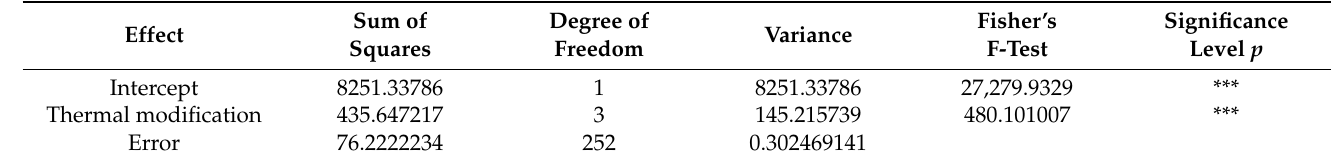
Table 4. Statistical evaluation of the factors affecting the change in the a * value.